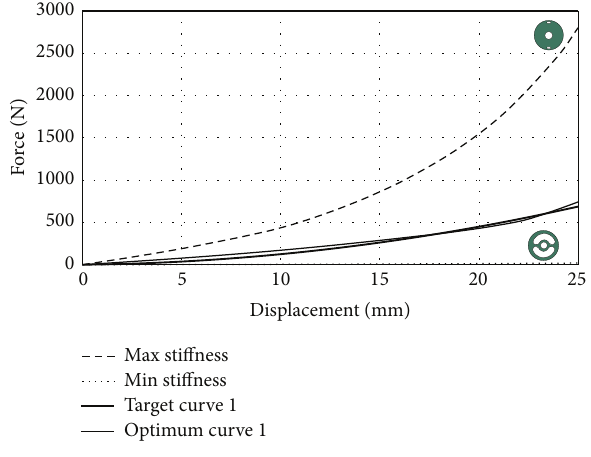
Figure 10: Optimization results for target curve 1.